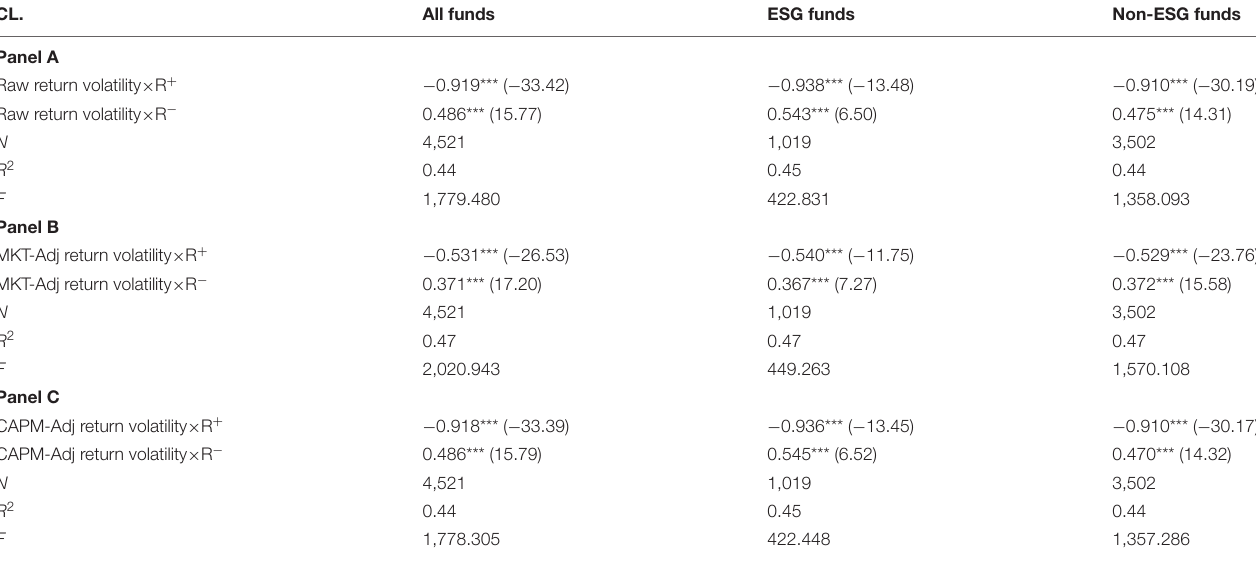
Table 7 is the result of comparing the fund flow–performance volatility sensitivity according to the type of past fund performance. The dependent variable is fund flow. Raw return is the average of returns over the previous 12 months; MKT-Adj return, the market-adjusted returns over the previous 12 months; CAPM-Adj return, CAPM-adjusted return over the previous 12 months; is the positive value for the raw return, MKT-Adj return, CAPM-Adj return, respectively, is the negative value for the raw return, MKT-Adj return, CAPM-Adj return, respectively, The content of the table is the regression coefficient value; the figure in parentheses, t-value; and ***, **, and * means that each is significant, respectively, at 1, 5, and